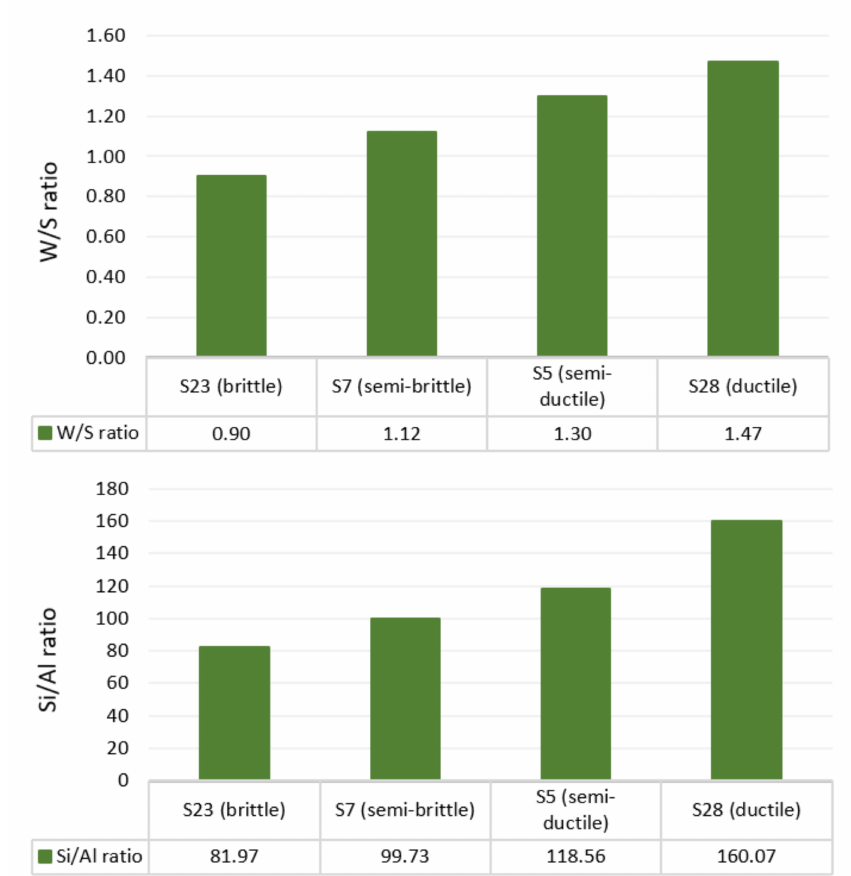
Figure 10. W/S ratio and Si/Al ratio in selected brittle and ductile samples.